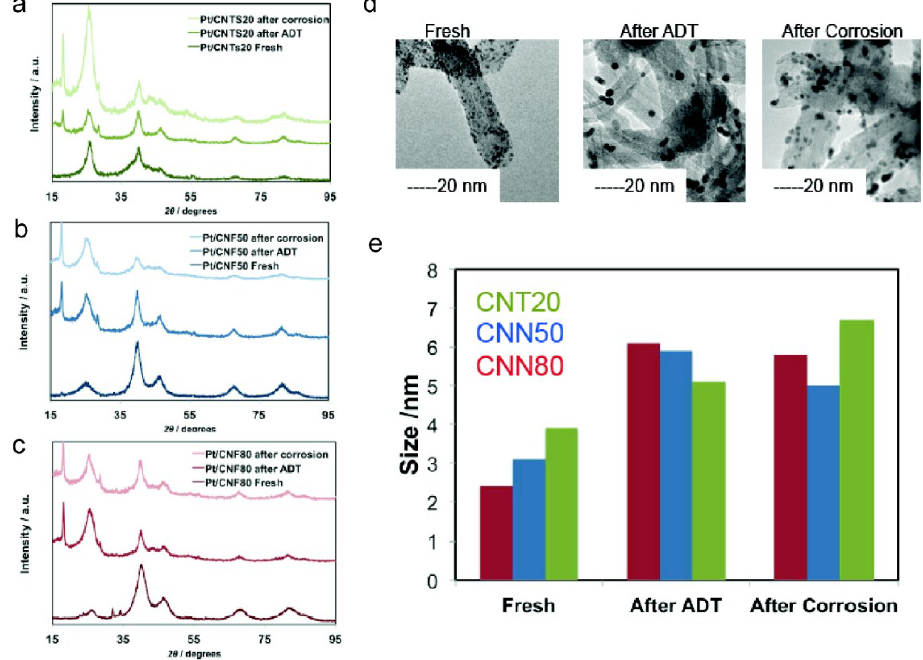
Figure 5. XRD measurements of electrocatalysts fresh, after ADT and after corrosion: ( a ) Pt/CNT20; ( b ) Pt/CNN50; ( c ) Pt/CNN80; ( d ) TEM images for Pt-CNT20 fresh, after ADT and after corrosion; ( e ) Pt particle size measured from XRD measurements for fresh, after ADT and after corrosion